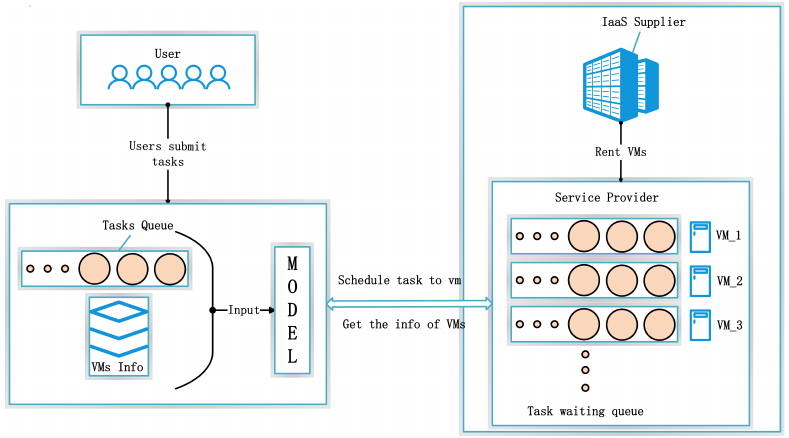
Figure 2. Task scheduling